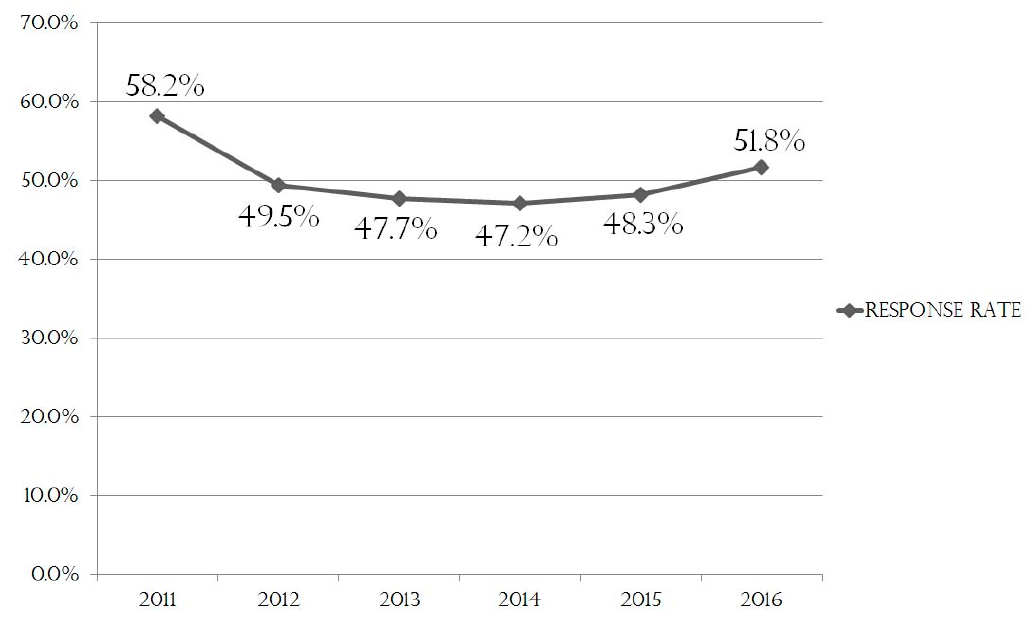
Figure 1. Overall response rate by year.